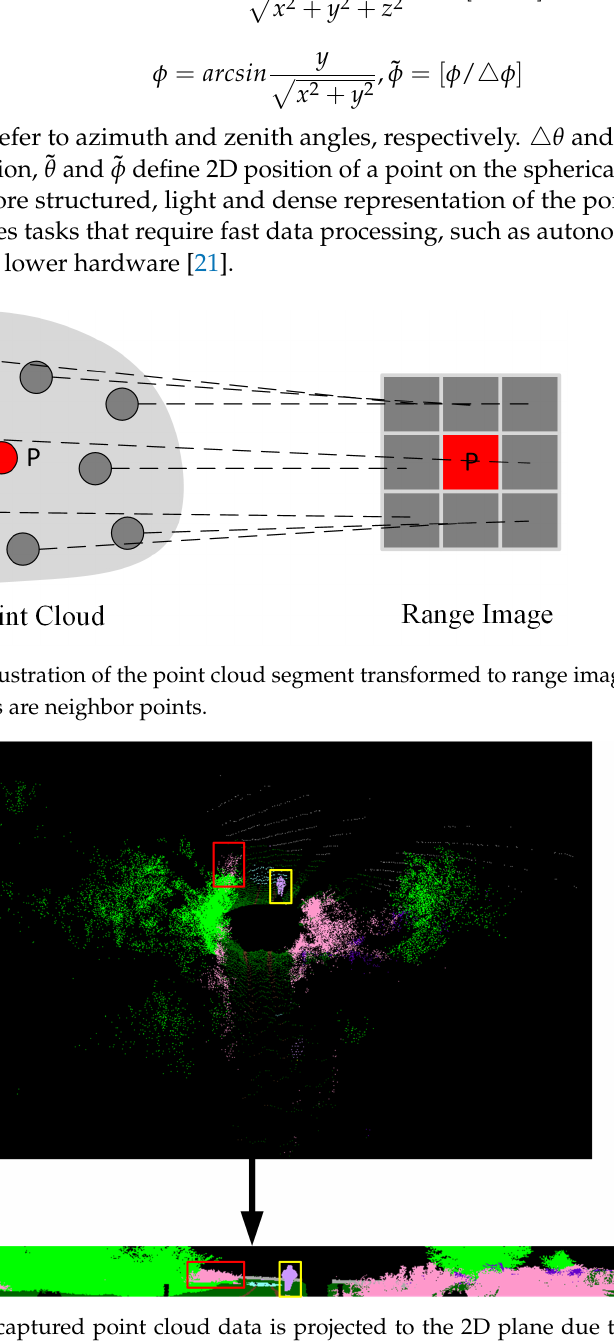
Figure 3. The captured point cloud data is projected to the 2D plane due to LiDAR parameters. Objects close to the sensor are denser, and the density decreases as you move away from the sensor. Some projected objects are marked with red and yellow